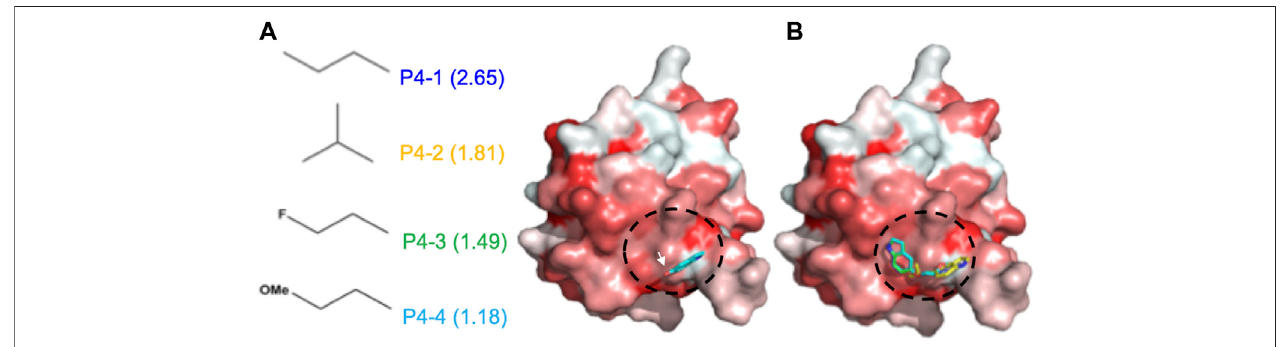
FIGURE 2 | Docking results of CoV N-NTD with 5-Hydroxyindole. (A) (left) The structures of each chemical moiety designed for 5-Hydroxyindole modi fi cation. The calculatedmiLogPvaluesofeachmoietywereshowninbrackets.(right)SurfacerepresentationofCoVN-NTDwiththeexpectedbindingsiteof5-Hydroxyindole,obtainedby using the molecular docking. The surface was colored according to the hydrophobicity level at the protein surface. The chemical moieties were designed to add to the hydroxyl group of 5-Hydroxyindole (indicated by white arrow) to increase the hydrophobic contacts between each compound and the expected binding surface (indicatedbyblack cycle) (B) Sameas (A) exceptthe5-Hydroxyindolewasreplacedby P4-1,P4-2, P4-3,andP4-4areshown inblue, yellow,greenand cyan,